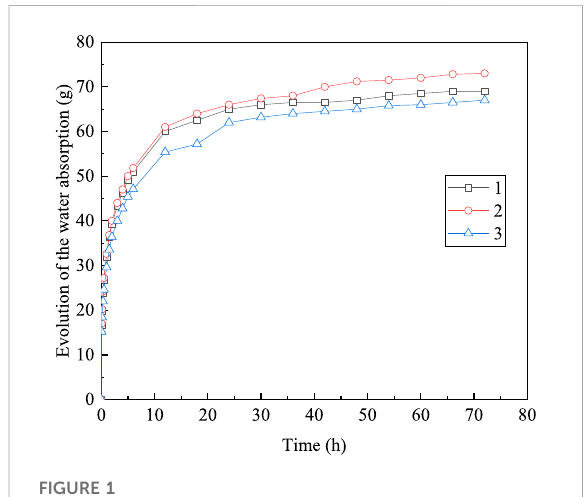
FIGURE 1 Water absorption of concrete in immersion process.